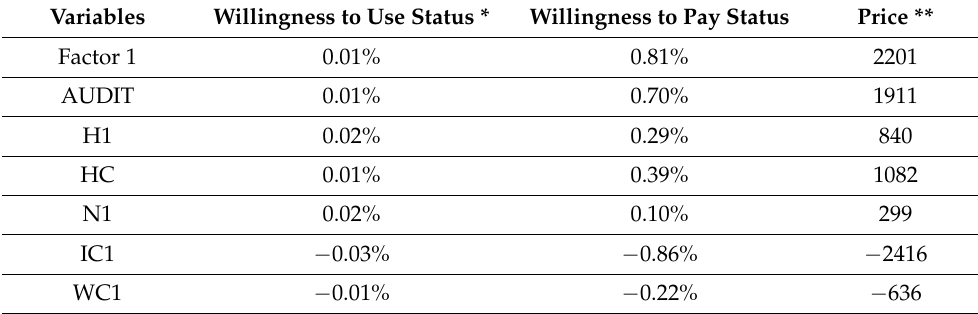
Table 11. Double-hurdle marginal probability results of drunk car drivers.